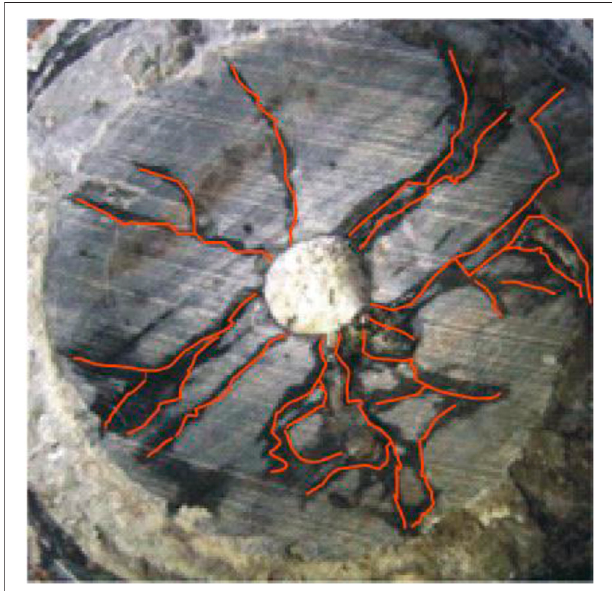
FIGURE 1 | Fracture network morphology in unconventional reservoirs (Guo et al.,